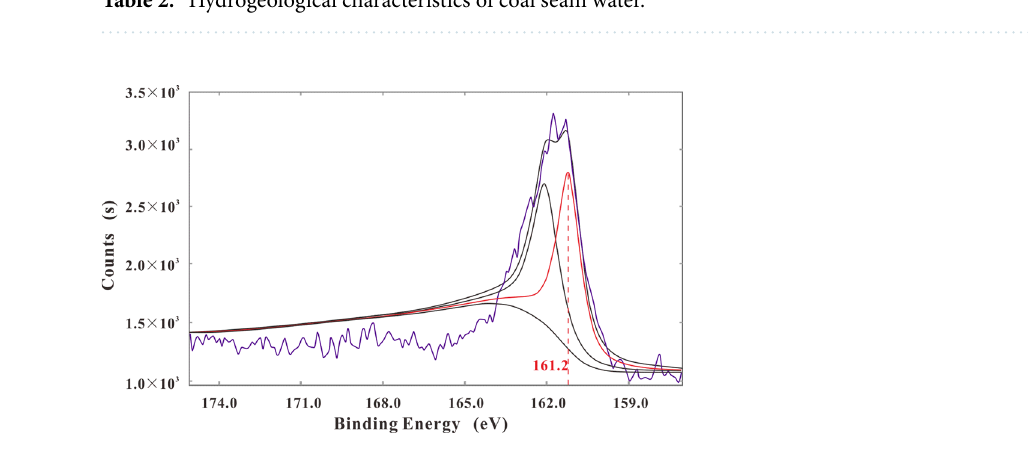
Table 2. Hydrogeological characteristics of coal seam water.